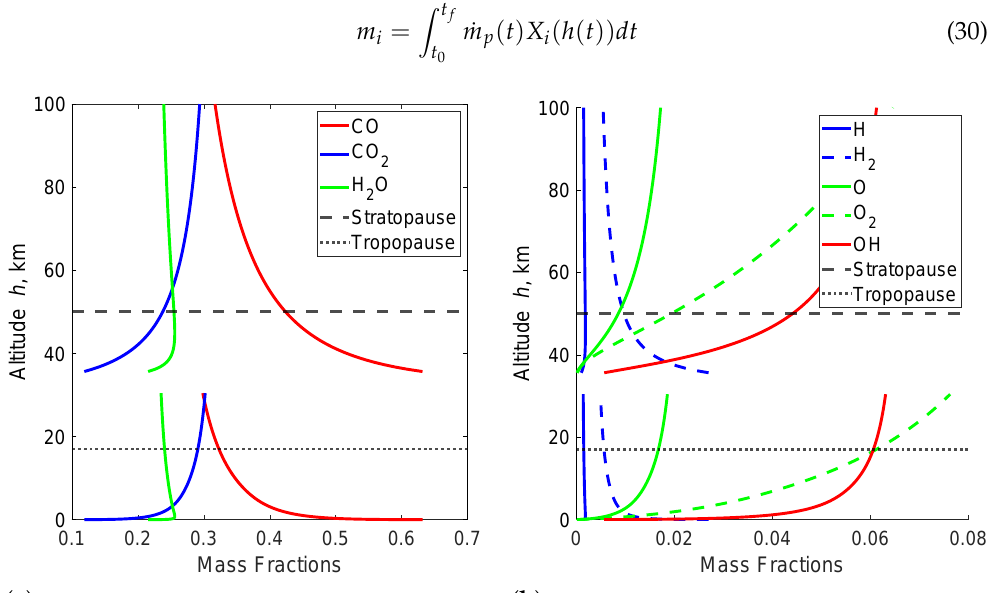
Figure 6. Mass fractions of the exhausted gases considered during launcher ascent: REF case. The gaps in the plots (at about 30 km altitude) correspond to the coast arc for the first stage jettisoning, where thrust and propellant mass flow are zero.